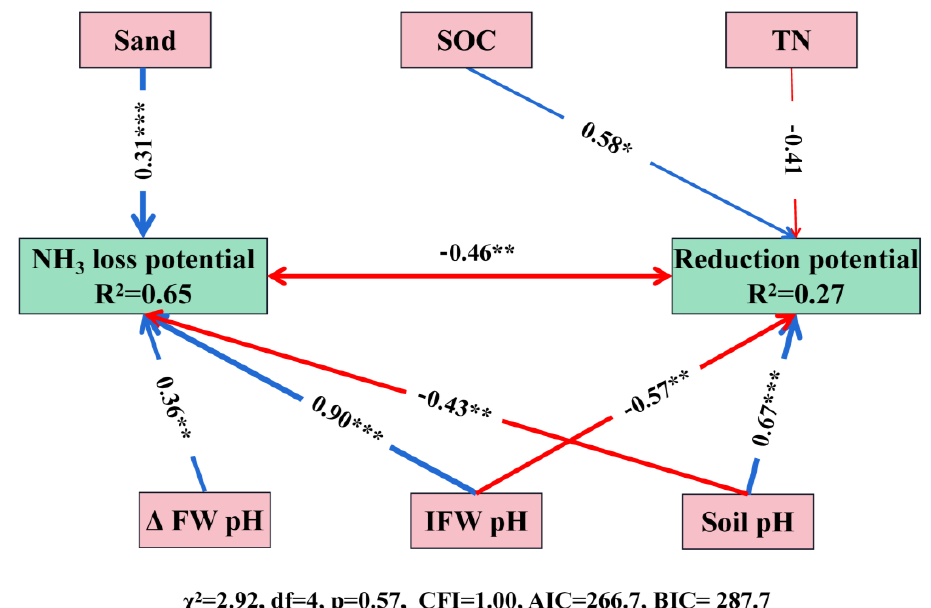
Figure 4. The structural equation model analysis of factors influencing NH 3 loss and the reduction potential of using the urease inhibitor. The NH 3 loss from 50 typical paddy soils under simulated flooded condition and the corresponding NH 3 reduction potential by using the Limus ® urease inhibitor (UI) were considered as the response variables. Soil and flooded water properties were explanatory variables. Blue and red arrows indicate positive and negative relationships, respectively. Numbers on the arrows indicated the standardized path coefficients, and asterisks show significant impacts of explanatory variable on the corresponding response variable, with *, **, and *** indicating significance levels at 0.05, 0.01, and 0.001, respectively. The thickness of the arrows indicates the magnitude of the